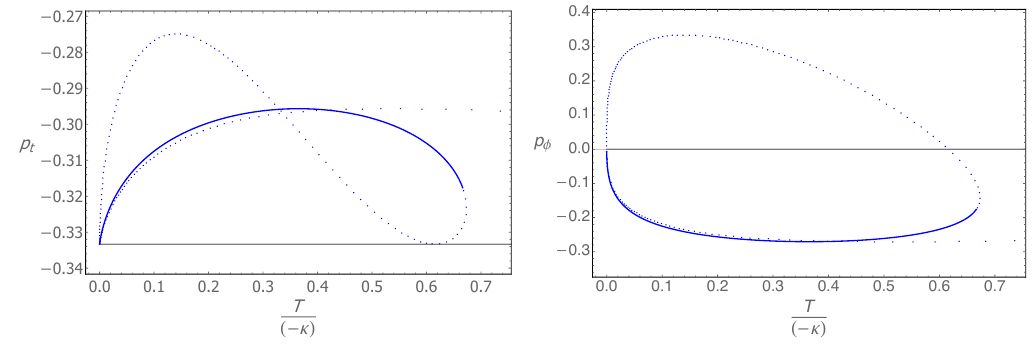
Figure 7 . The Kasner exponents p t ( left ) and p φ ( right ) of the black hole solutions as a function of T/ ( − κ ) . In both plots, the gray line is for Schwartzschild black hole, the solid blue line is for stable hairy black hole solution while the dotted blue lines are for unstable hairy black hole